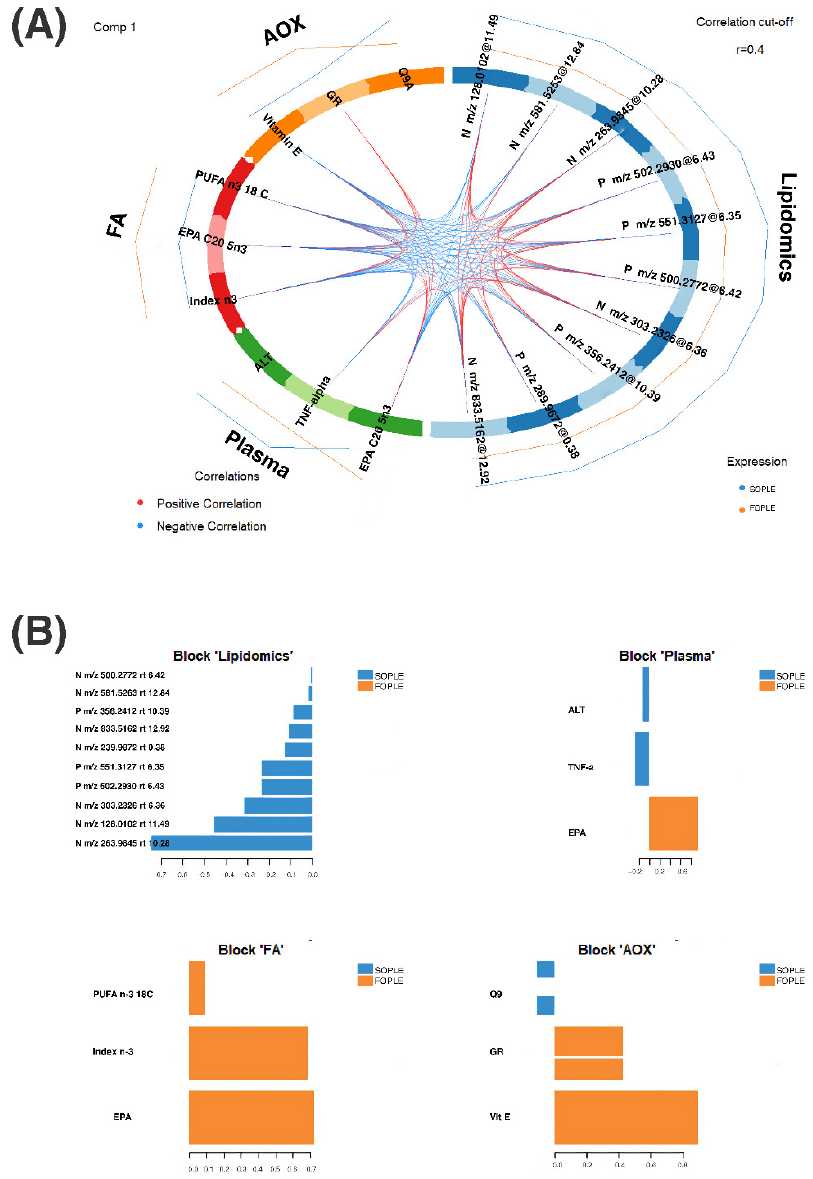
Figure 4. ( A ) Circos plot representing the connection between the different blocks of data and the correlation among the different variables in children after hematopoietic stem cell transplantation using two different parenteral nutrition lipid emulsions. ALT: alanine-aminotransferase; AOX: antioxidant block in plasma; EPA: eicosapentaenoic acid; FA: fatty acids block in erythrocytes; FOPLE: FO-based formula; GR: glutathione reductase; PUFA: polyunsaturated fatty acids; SOPLE: SO-based formula. The variables from the lipidomics block are labeled according to the ionization mode, positive or negative, the m / z , and the retention time. Pairs of variables were selected according to a correlation cut-off of r < 0.04. The different colors in the circle indicate the different data blocks, whereas the inner lines correspond to the correlation between pairs of variables. The outer lines represent the trend on each group for each variable. ( B ) The plot represents the loading weights of each selected variable on component one and for each data block. The color indicates the class where the variable has the maximum level as per the median. ALT: alanine-aminotransferase; AOX: antioxidant block in plasma; EPA: eicosapentaenoic acid; FA: fatty acids block in erythrocytes; FOPLE: FO-based formula; GR: glutathione reductase; PUFA: polyunsaturated fatty acids; SOPLE: SO-based formula. The variables from the lipidomics block are labeled according to the ionization mode, positive or negative, the m / z , and the retention time.